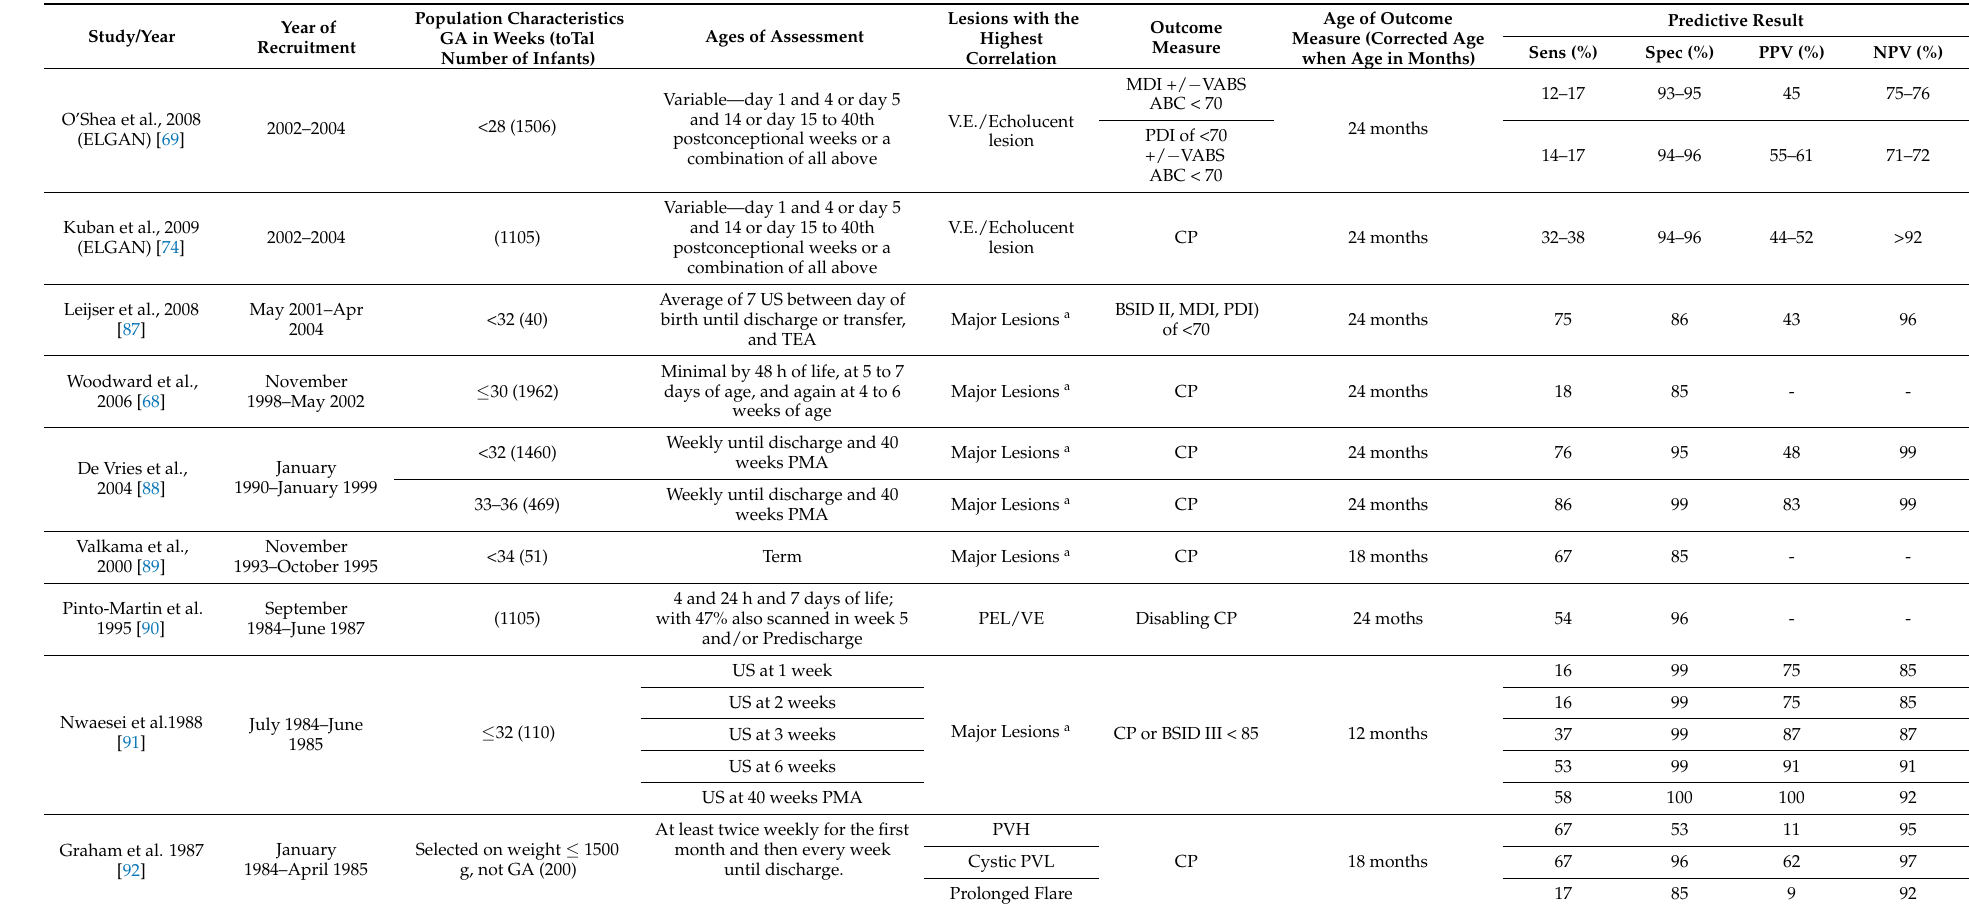
Table 2. The predictive value of the cranial ultrasound in preterm